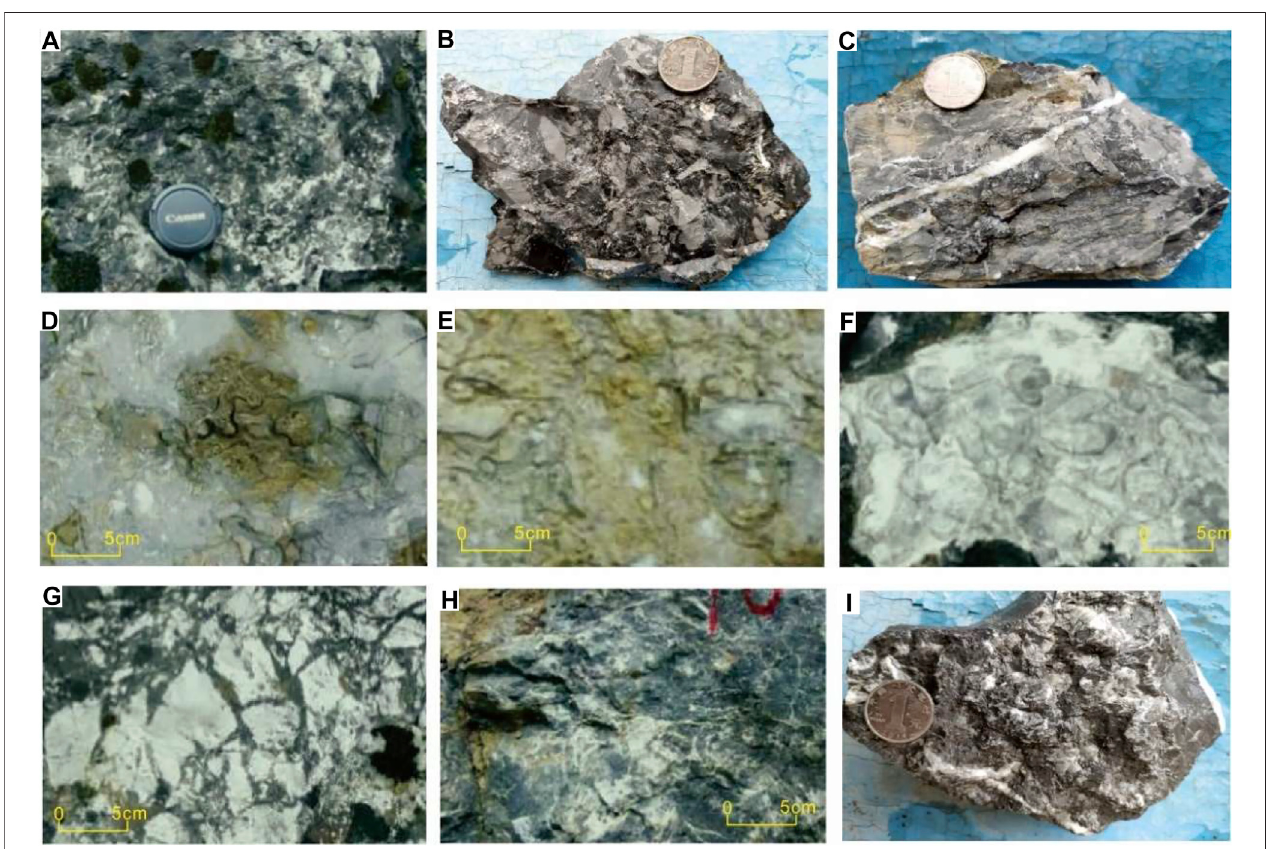
FIGURE 4 | Lithology and biology of Changxing Formation reef in outcrop of Jiantianba. (A,B) Algal reef limestone, mainly composed of blue-green algae, content upto65%; (C,D) algalbondedspongereeflimestone,withabout25%spongecontentand35%blue-greenalgaecontent,hasobviousalgalbonded — barrierstructure; (E) sponge skeleton reeflimestone, with obviousbarrier — skeletonstructure, reef-building organisms are mainly string sponges and fi ber sponges, thecontentofwhich is about 60%; (F) skeleton reef limestone, with biological skeleton structure, reef-building organisms are mainly string sponges, fi ber sponges, etc., (G) limestone breccia, breccia for angular,for the collapse ofthe reef formation; (H,I) lightgrey blocky dolomitic reef limestone, fracture and dissolution ofthe geode is developed well.